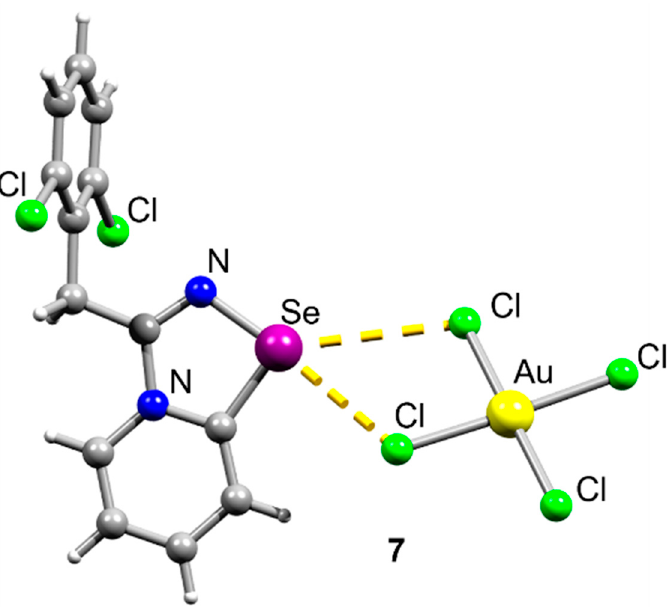
Figure 5. Ball-and-stick representation of crystal structure of 7 , demonstrating Se · · · Cl ChB interactions. Grey and light-grey spheres represent carbon and hydrogen, respectively.